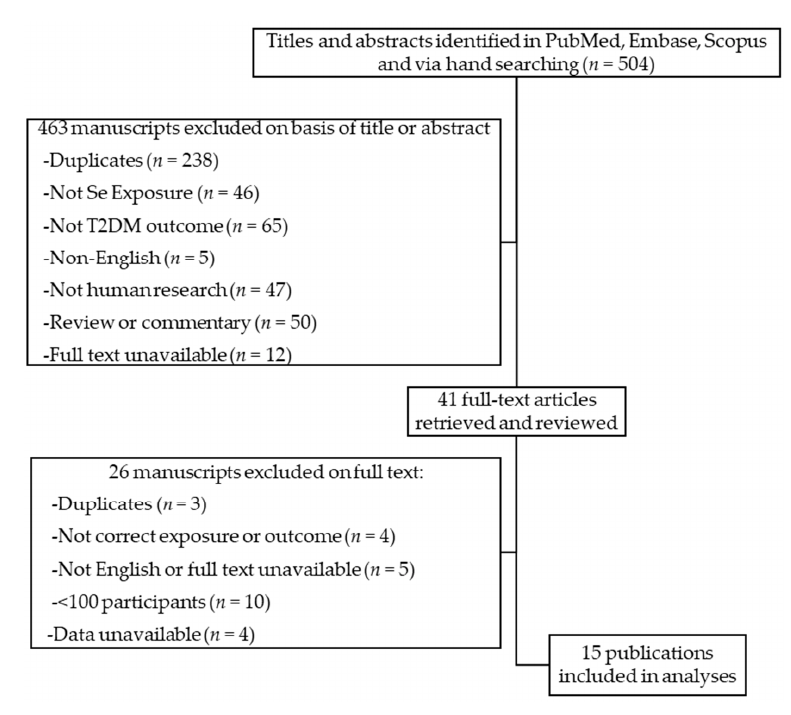
Figure 1. Manuscript selection flowchart. We identified 15 manuscripts that met the a priori criteria for inclusion. These are described in